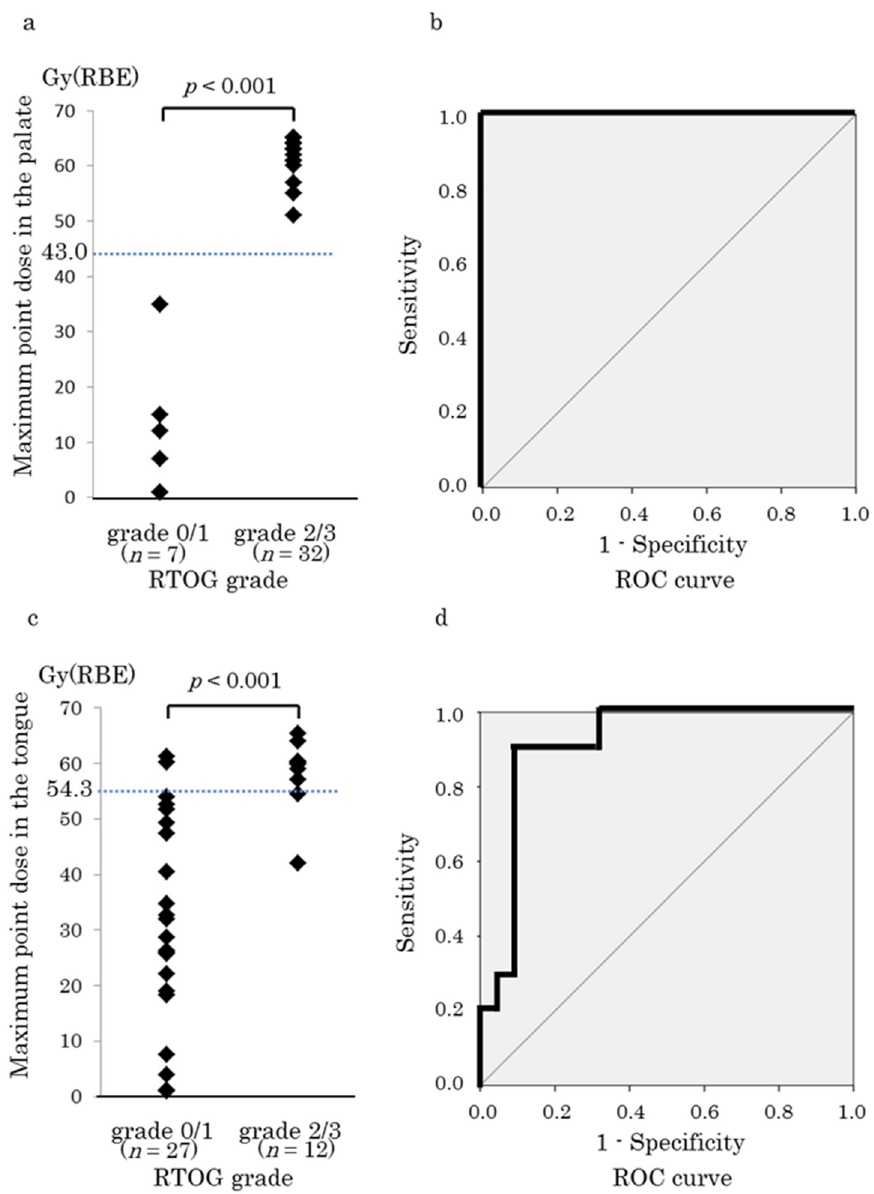
Fig 3. Relationship between the maximum point dose in the oral mucosal dose surface model and acute radiation mucositis (ARM) grade (Radiation Therapy Oncology Group [RTOG] classification). (a) Maximum doses in the palate for grade 0 – 1 and grade 2 – 3 ARM. (b) Receiver operating characteristics (ROC) curve for grade 2 – 3 ARM in the palate (sensitivity, 1.0; specificity, 1.0). (c) Maximum doses in the tongue for grade 0 – 1 and grade 2 – 3 ARM. (d) ROC curve for grade 2 – 3 ARM in the tongue (sensitivity, 0.9; specificity, 0.9). Data are presented as mean ± standard deviation. RBE, relative biological effectiveness.